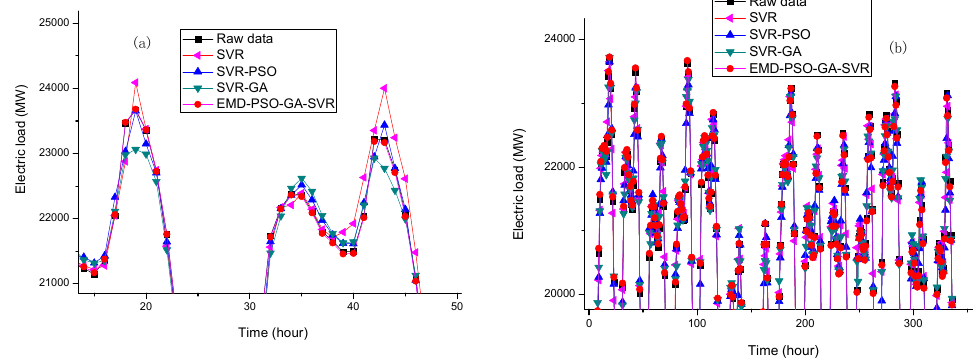
Figure 14. Forecasting performance comparisons (Example 2). ( a ) One-day ahead forecasting from 13 to 14 January 2015; ( b ) One-week ahead forecasting from 2 to 15 February 2015.